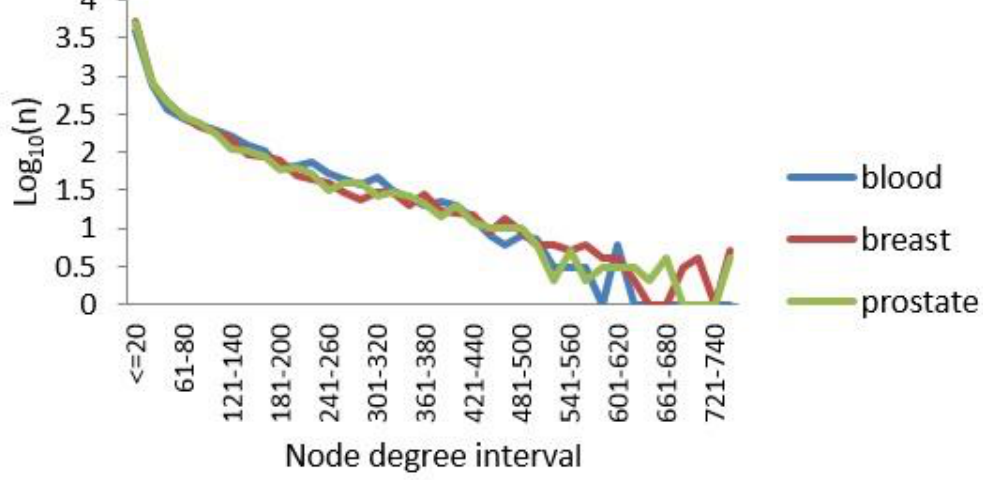
Figure 3. Node degree distributions for the three TSPPI networks. The X axis represents the distribution interval of the node degree. The Y axis represents Log 10 (n), where n is the number of nodes.